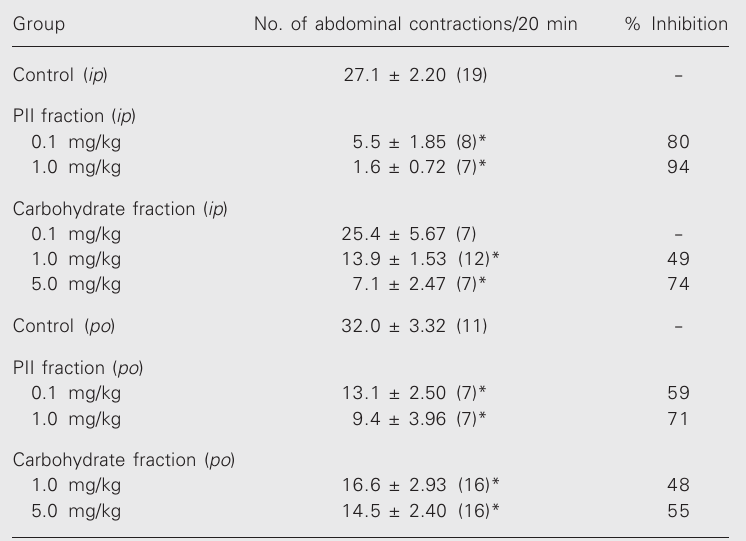
Table 1. Antinociceptive effect of PII and carbohydrate fractions from Bryothamnion seaforthii on acetic acid-induced abdominal contractions in female Swiss mice.